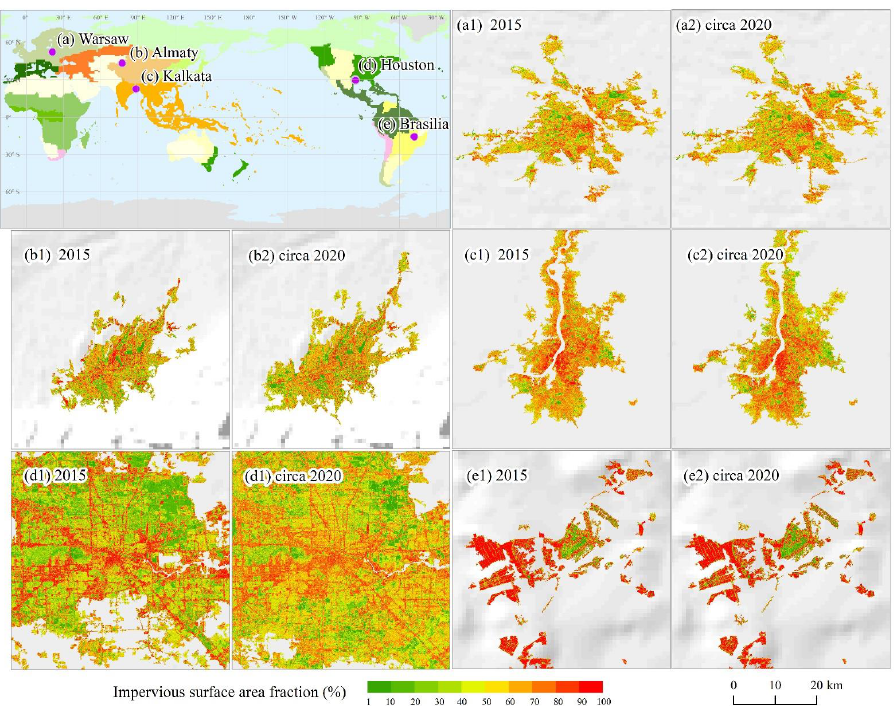
Figure 6. Examples of urban impervious surface area fraction in selected cities. ( a1 ), ( b1 ), ( c1 ), ( d1 ) and ( e1 ) show the urban impervious surface area fraction in 2005; ( a 2 ), ( b2 ), ( c2 ), ( d2 ) and ( e2 ) show the urban impervious surface area fraction circa 2020 .